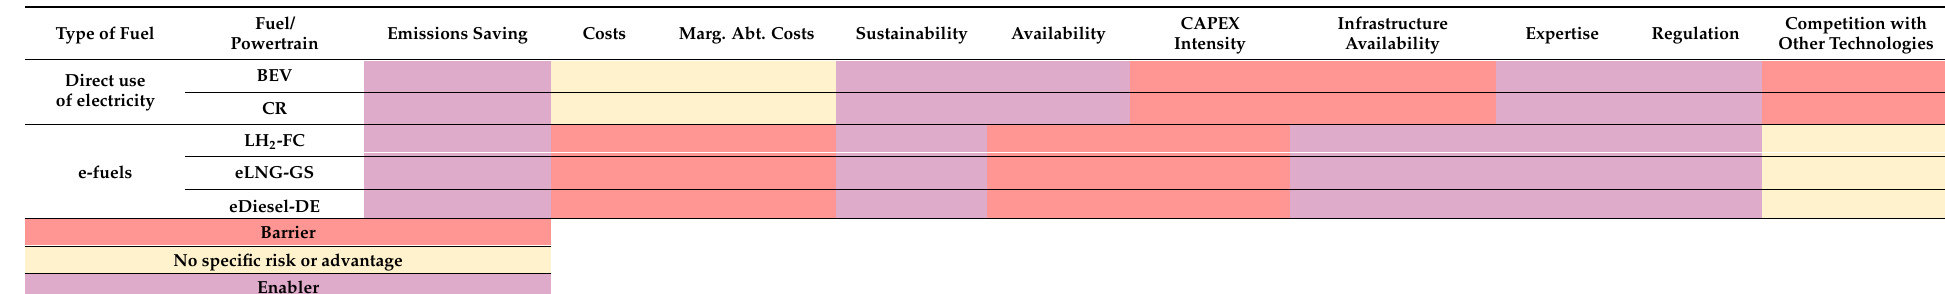
Table 8. Technical and non-technical